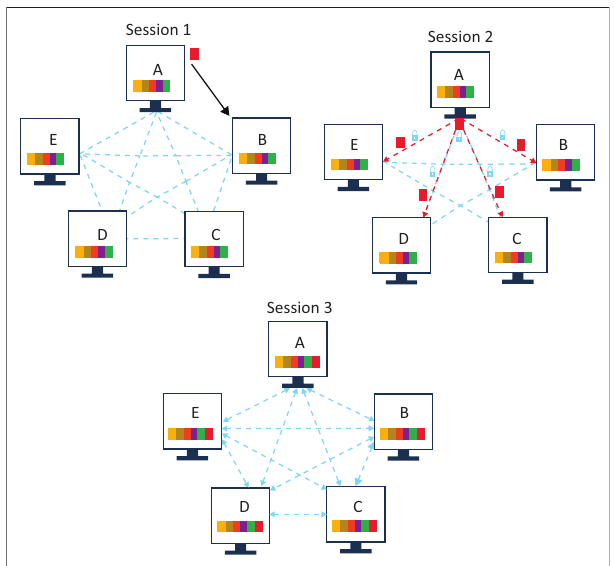
EHR, electronic health record. FIGURE 4: The flow of research method used for the study.